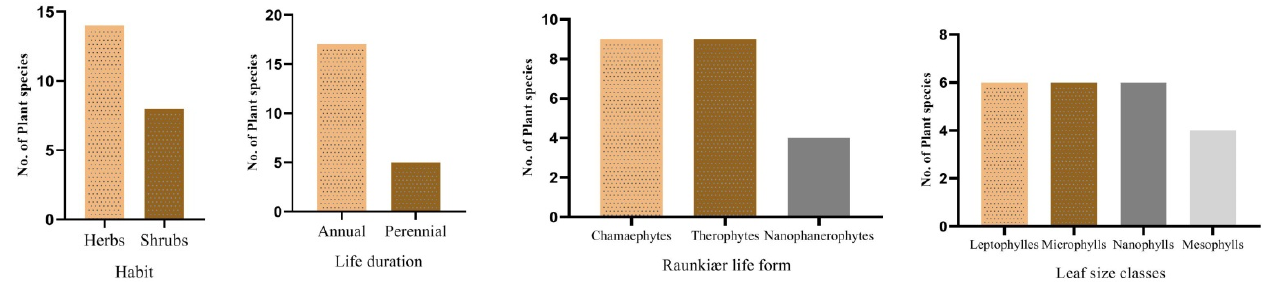
Figure 3. Floristic characteristics of the vegetation found in association with Silybum marianum in communities (Details available in Supplementary Table S1). Table 2. Importance value index of Silybum marianum and associated species found in the three groups separated by cluster